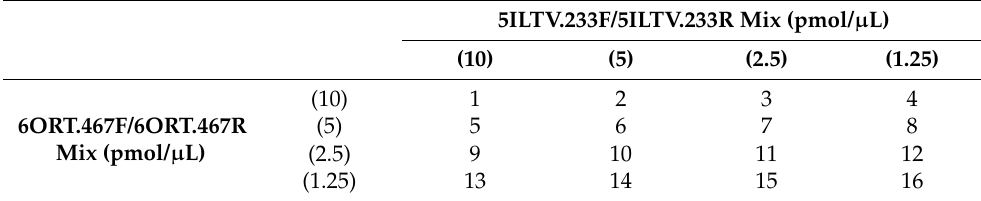
Table 3. Experiment design to determine the optimal combination of